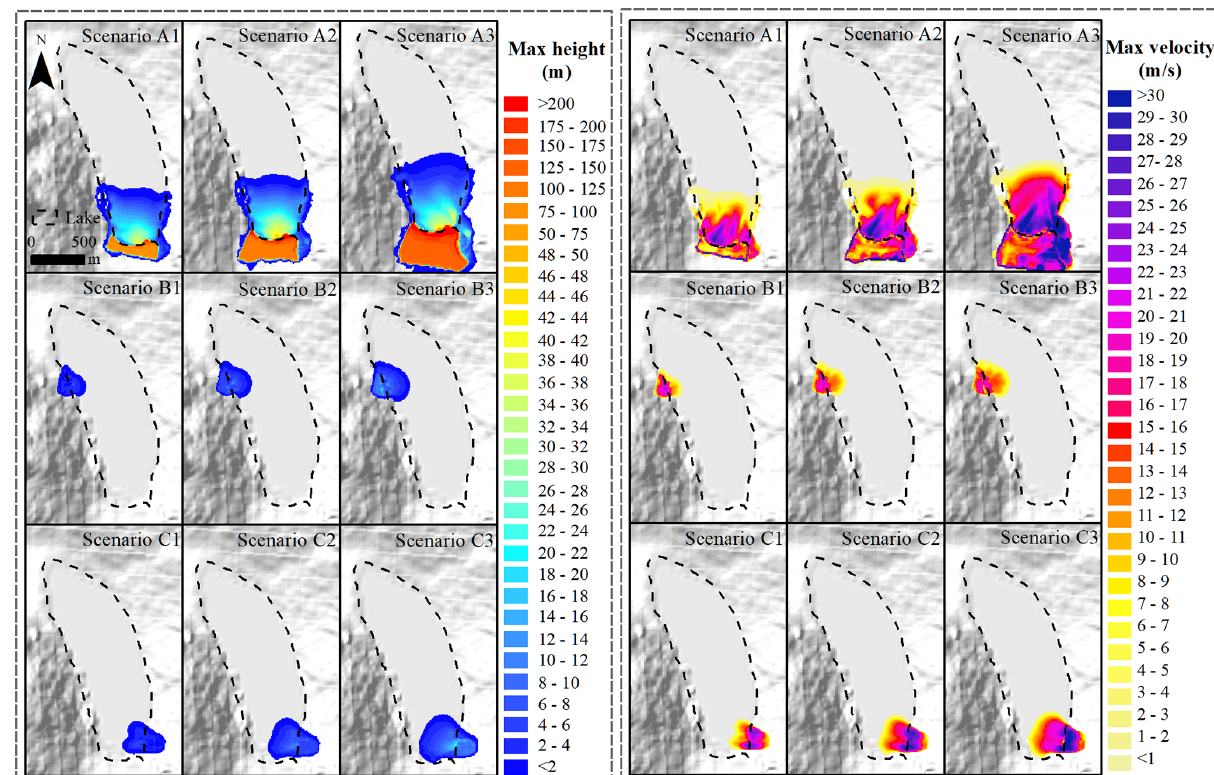
Figure 6. Maximum flow height (left) and maximum flow velocity (right) for different ice avalanches and landslide scenarios.